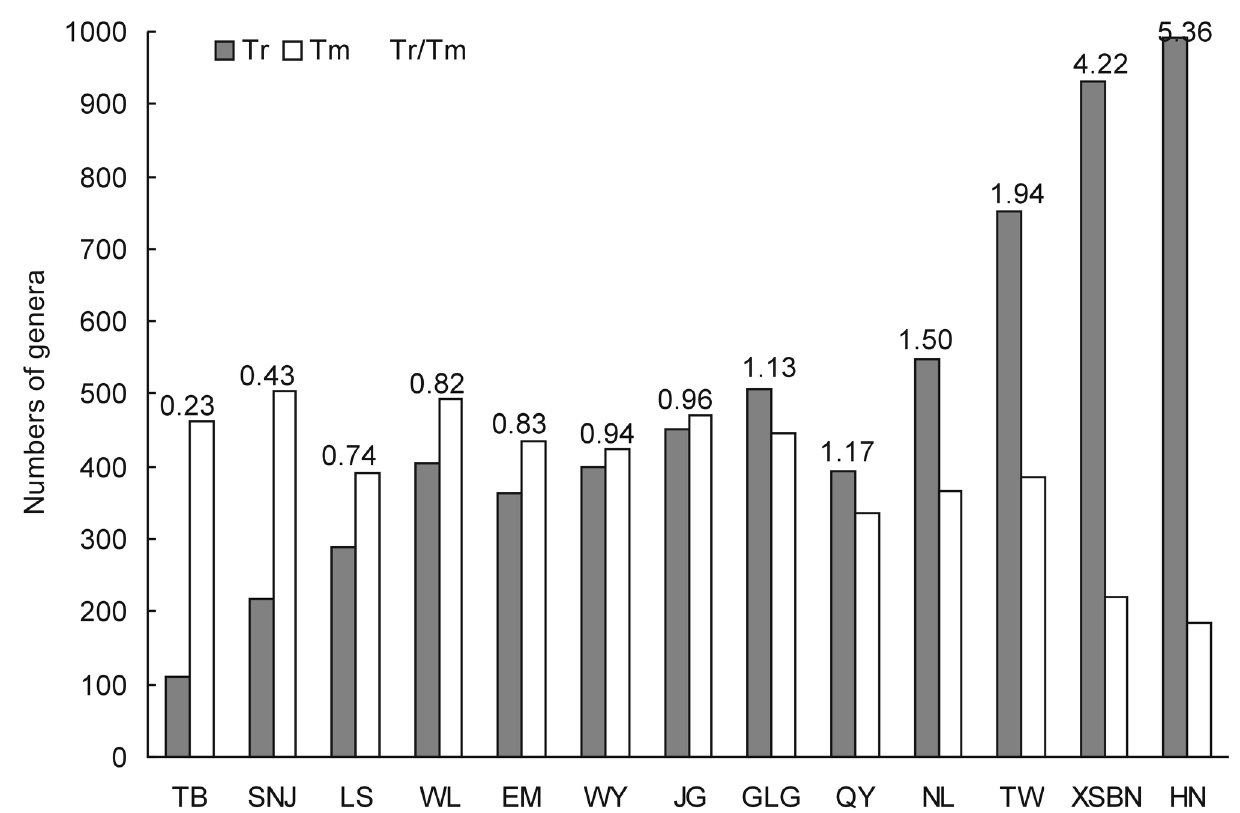
Figure 2. Numbers and ratios of the tropical genera and the temperate genera in Mount Jinggangshan region and other twelve mounts in China. doi: